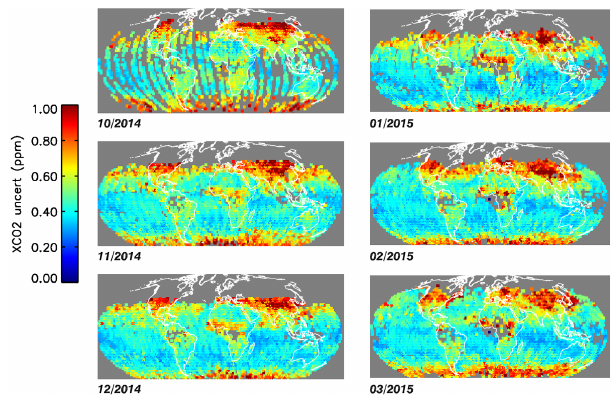
Figure 10. Maps of the average X CO data product. Statistics are provided for 2 ◦ by 2 ◦ bins for data se- lected with the data quality